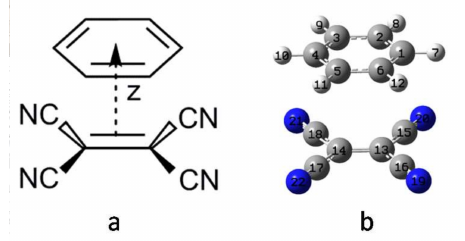
Figure 6. ( a ) The molecular structure of the B-TCNE complex model with cofacial configuration; Z is the distance between molecular centers; ( b ) The cofacial configuration of the B-TCNE complex constructed by the optimized monomer. The atomic serial numbers are also given. The colored circles present different types of atoms (blue: N; grey: C; light grey: